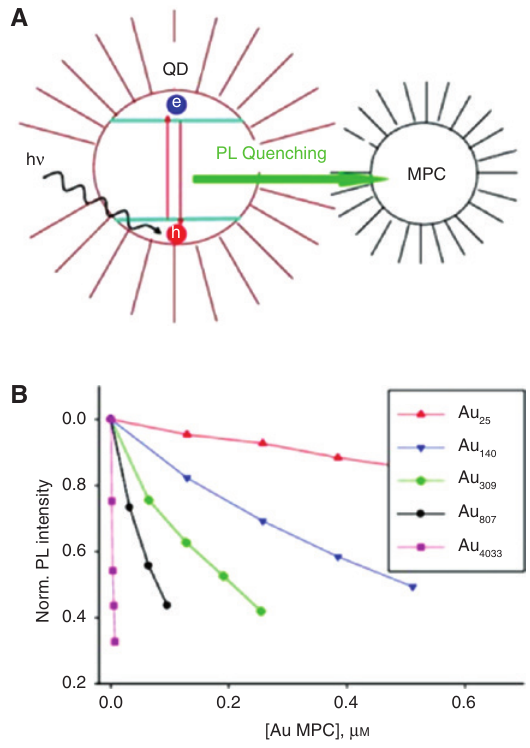
Figure 14: Fluorescence quenching of QDs by plasmonic